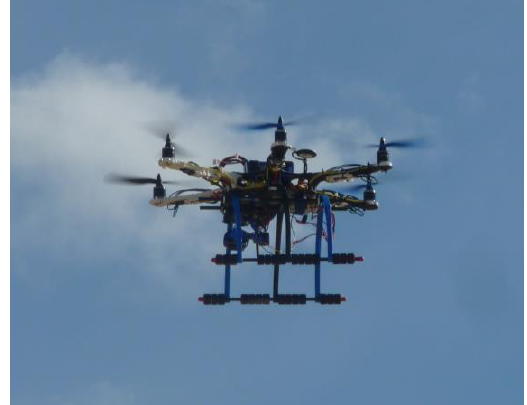
Figure 2: The UAV used during the flights, based on a modify F550 DJI